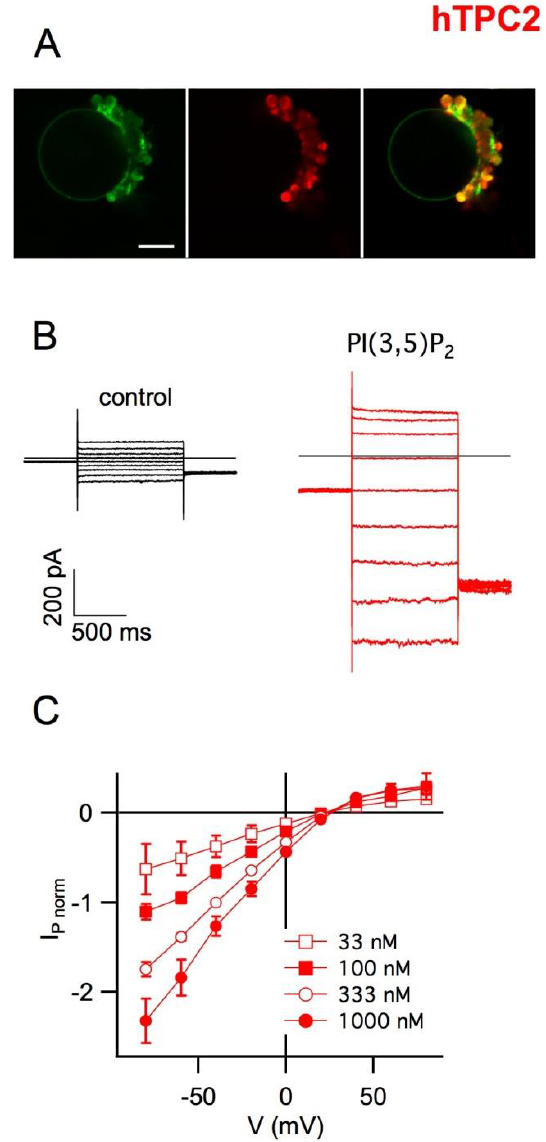
Figure 3. Functional characterization of human TPC2in plant vacuole as heterologous